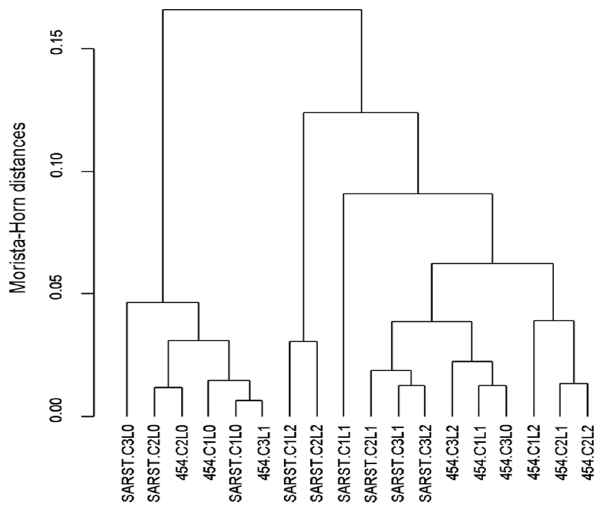
Figure 5. Dendrogram obtained from UPGMA grouping of the Morista-Horn distances of the relative abundance of the genera. L0: control; L1: 0.5 g/d yeast; L2: 5 g/d yeast; 454: 454 pyrosequencing method; SARST: SARST sequencing method. (C1, C2 & C3=cow 1, 3 or 3).